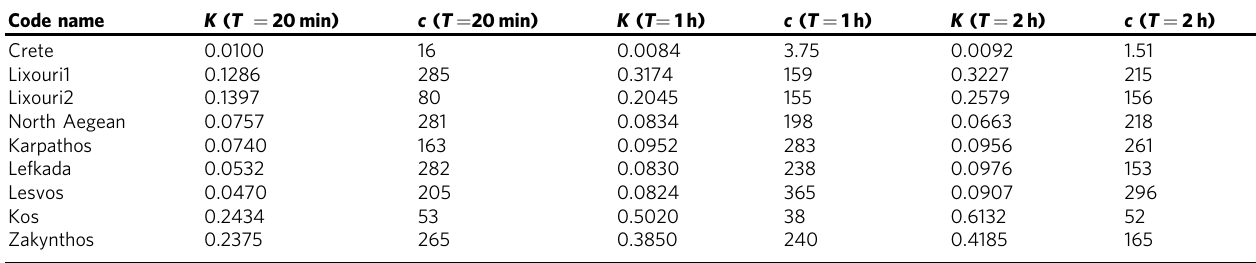
Table 3 The estimated parameters K and c